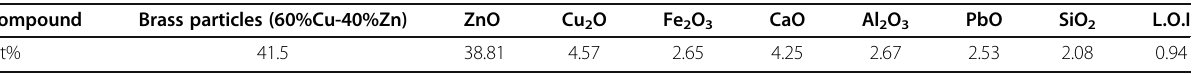
Table 1 Chemical analysis of sieved brass slag (D < 4000 μ m) Compound